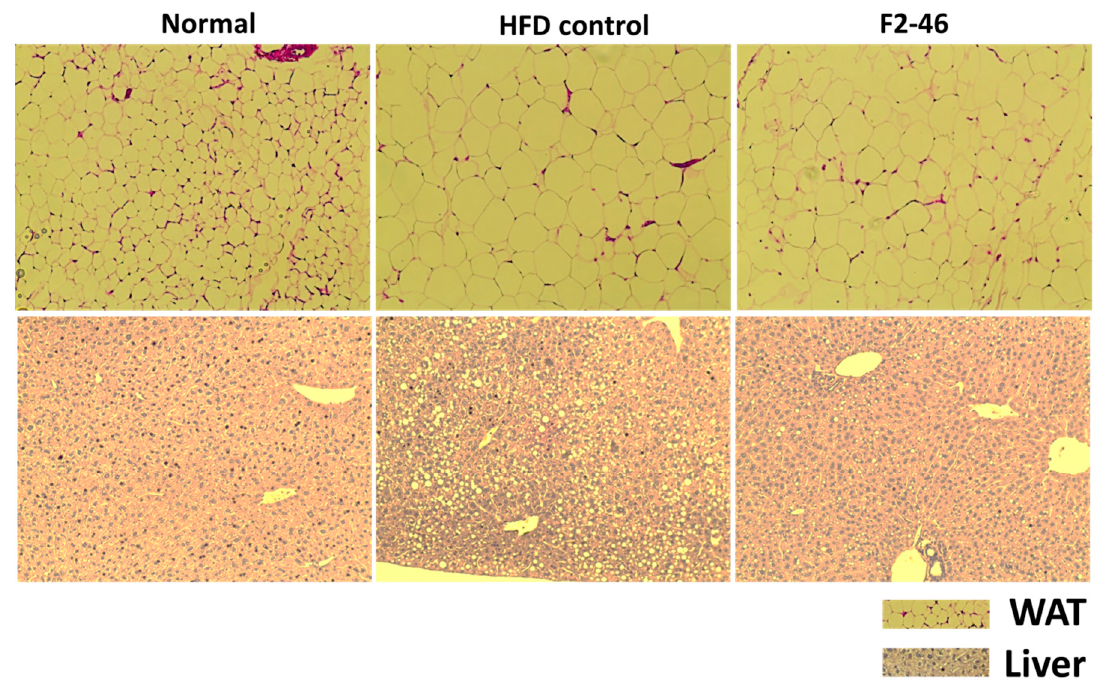
Figure 6. The effect of formulation F2 on the liver and WAT of obese mice. H&E staining was performed for the histological analysis (magnification ×20). The size of adipocytes in the WAT and deposition of lipid (yellow droplet) in the liver were evaluated. Normal = standard diet; HFD control = high-fat diet control; F2-46 = F2 (46 mg/kg).